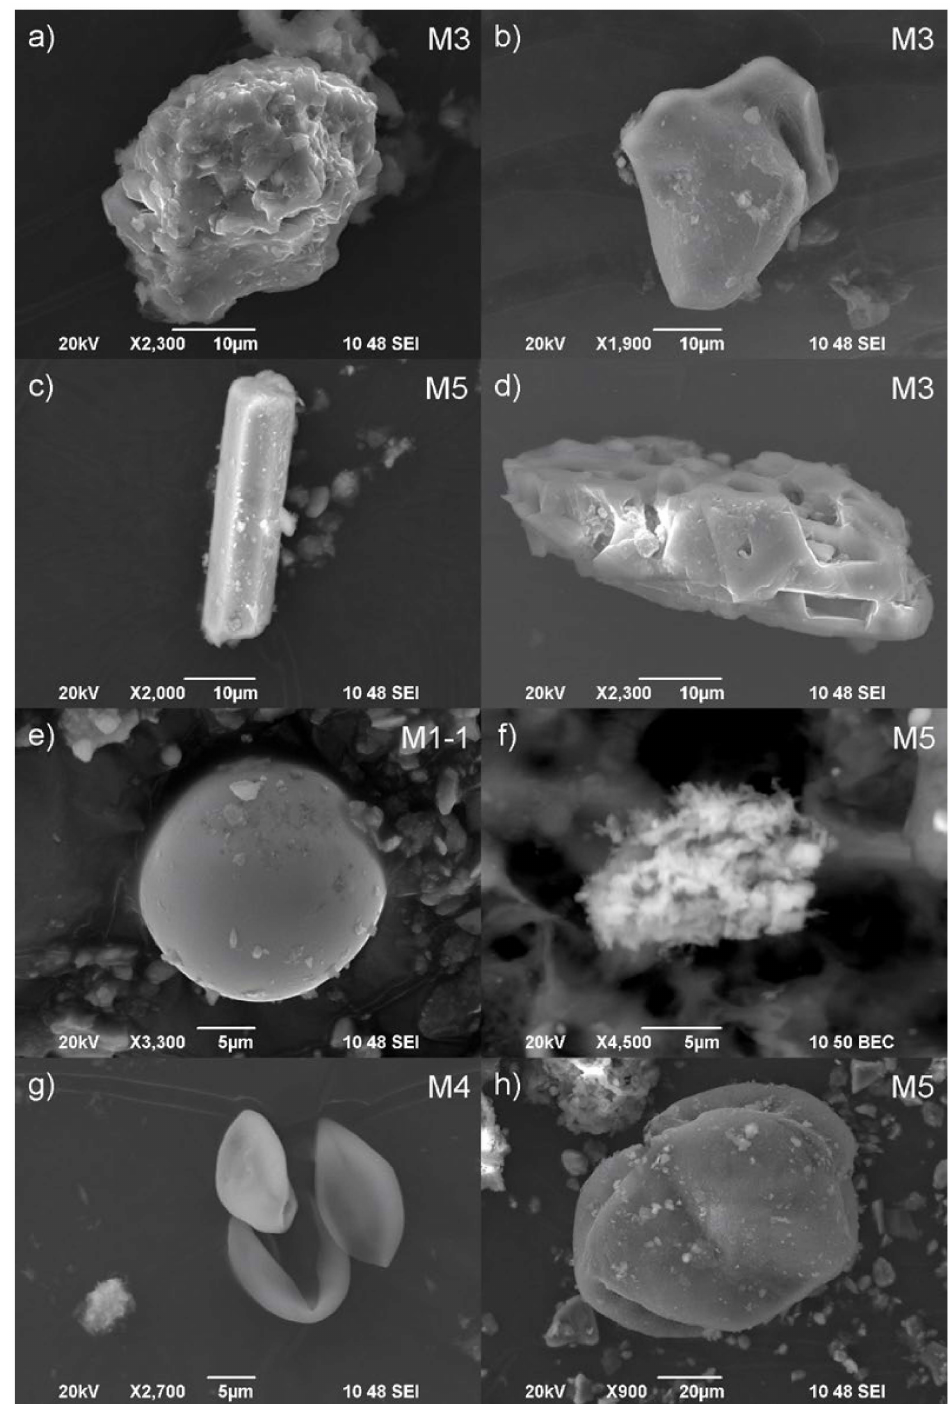
Figure 7. Particles from snowmelt water. Presented images are taken in SEI or BSE modes as indicated in the lower right corner of images. The sample code is marked in the upper right corner of each figure. ( a ) Si-O (quartz); ( b ) and ( c ) aluminosilicates with simple composition (Al-Si-O); ( d ) aluminosilicate (Si-Al-Na-O); ( e ) spherical aluminosilicate (Si-Al-K-Ca-O); ( f ) crystalline structure of carbonate (Ca-C-O, calcite or aragonite) with elevated content of Mg; ( g ) organic particles (spores on the right of the image) and crystalline structure of Ca-C-O (calcite or aragonite in the lower left corner of image); ( h ) organic particle spore covered with small aluminosilicate particles. Some spectra are provided in Supplementary Figure